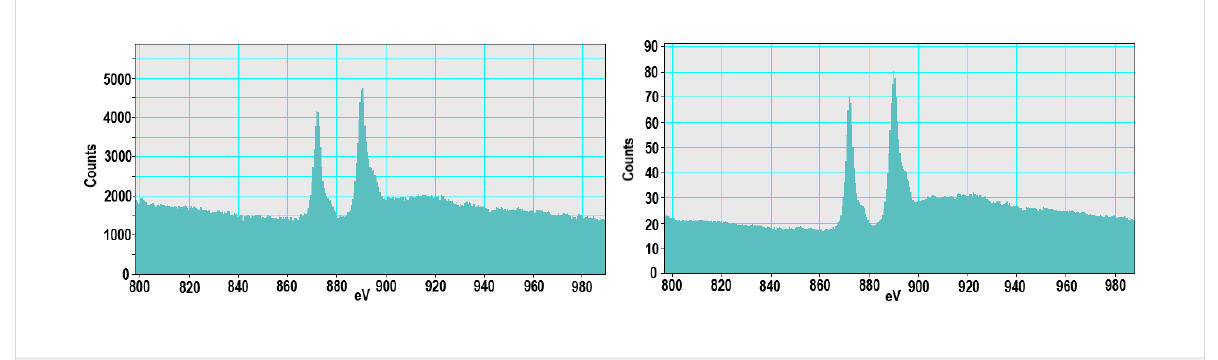
Figure 2: NM-212 cerium valence determined by electron energy loss spectroscopy. The left image was obtained at the edge, the right image at the ENM core.